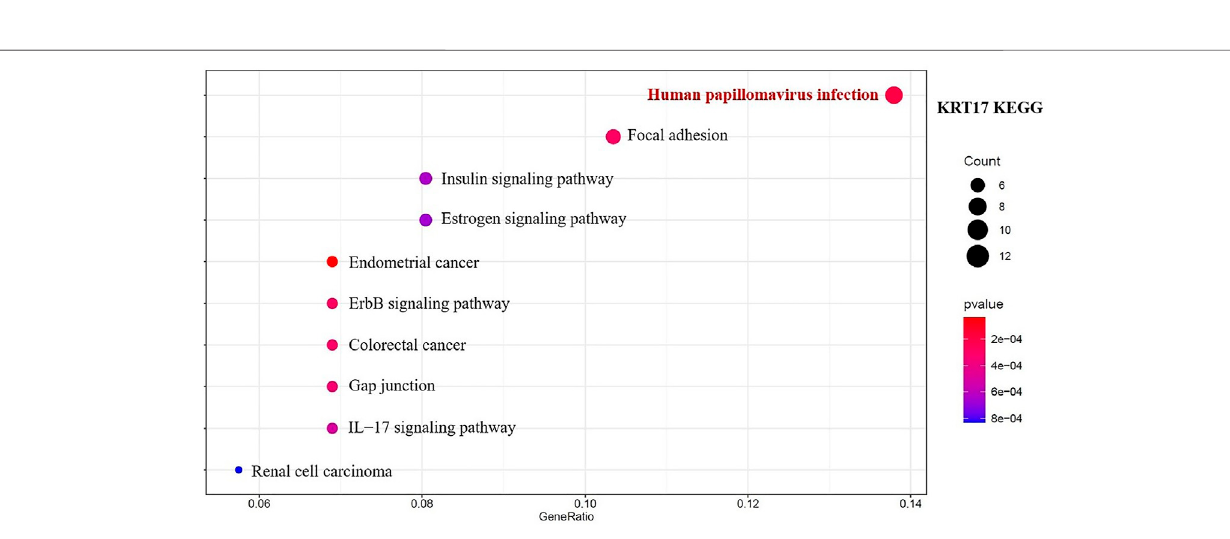
FIGURE 15 | Results of KEGG pathway analysis of KRT17 interaction binding and expression-related